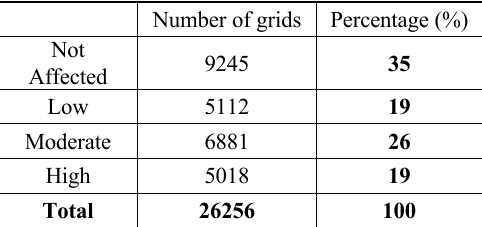
Table 9. Total number of grids in Palauig,